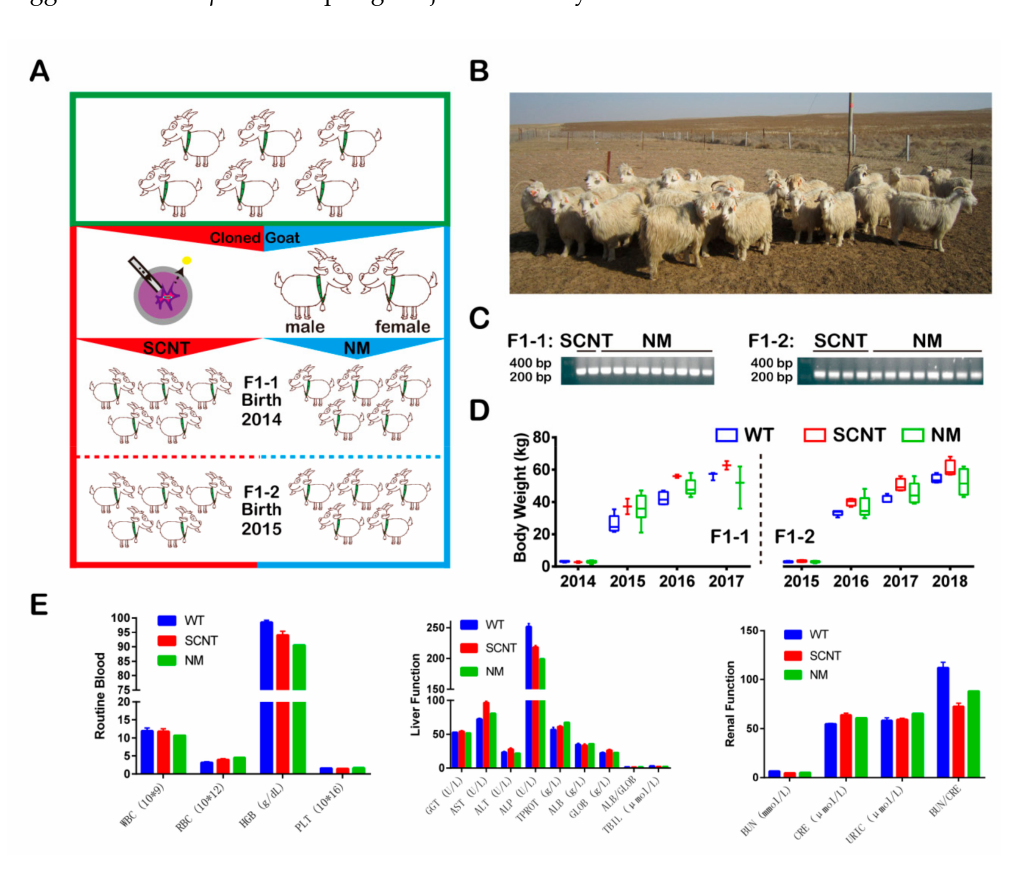
Figure 1. Establishment of the thymosin β 4 overexpression (T β 4-OE) germline. ( A ) A schematic showing germline transmission. ( B ) T β 4-OE first filial generation of 2014 (F1-1, a total of 11; via NM, F1-1-NM, a total of 9; via SCNT, F1-1-SCNT, a total of 2), and 2015 (F1-2, a total of 12; via NM, F1-2-NM, a total of 8; via SCNT, F1-2-SCNT, a total of 8). ( C ) PCR genotyping, showing the insertion of donor DNA in the T β 4-OE goats. SCNT: o ff spring produced by somatic nuclear transfer: NM: o ff springs produced by natural mating. ( D ) Body weights of the F1-1 and F1-2 from birth to four years old. CON: control. ( E ) Physiological indexes of the F1-1 and F1-2. Analytical measurements included routine blood count (white blood cell (WBC), red blood cells (RBC), hemoglobin (HGB) and, platelet (PLT)), liver function (gamma-glutamyltransferase (GGT), aspartate aminotransferase (AST), alanine transaminase (ALT), alkaline phosphatase (ALP), total protein (TPROT), albumin (ALB), globulin (GLOB), and total bilirubin (TBIL)) and renal function tests (blood urea nitrogen (BUN), serum creatinine (CRE), and blood uric acid